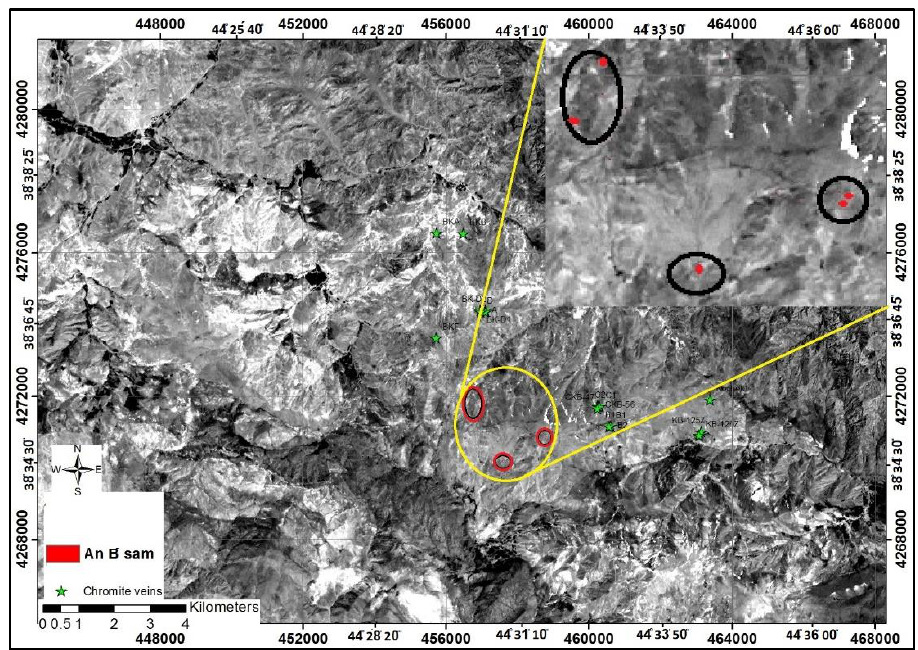
Figure 17. Chromitite-bearing pixels obtained from Anomaly B spectra and SAM in ASTER data.